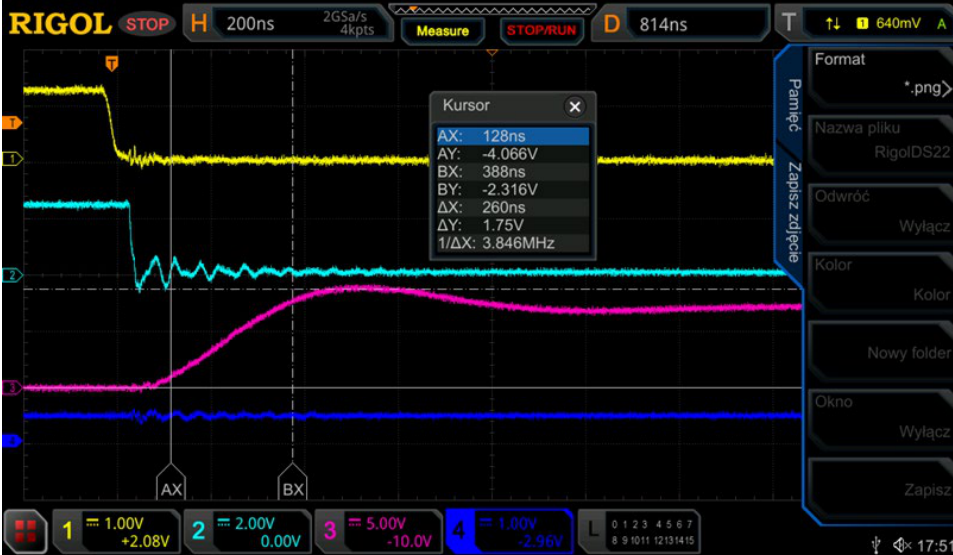
Figure 14. Oscillogram of the 260 ns gate pulse rising slope di g / dt .